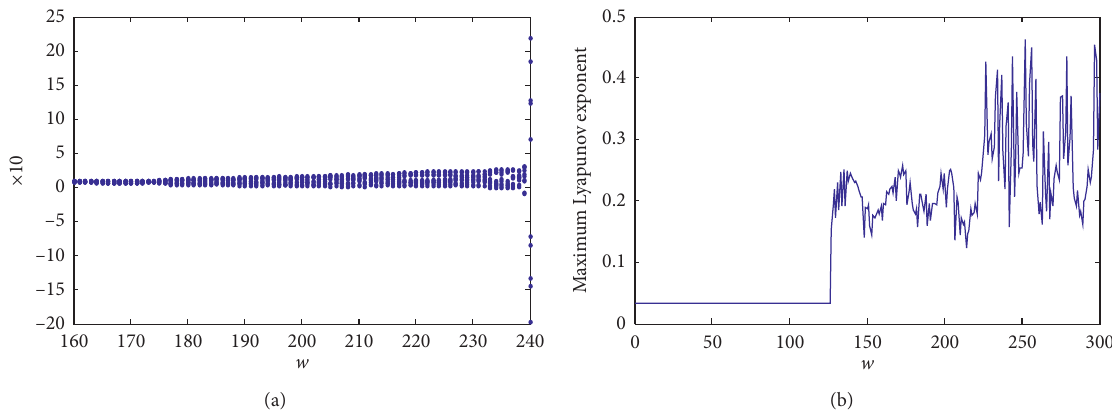
Figure 39: (a) Vibrational bifurcation diagram with the smoothed Coulomb model when t ∈ 0 . 0597 0 . 0921 􏼂 􏼃 . (b) Maximum Lyapunov exponent curve with the smoothed Coulomb model when t ∈ 0 . 0597 0 . 0921 􏼂 􏼃 .